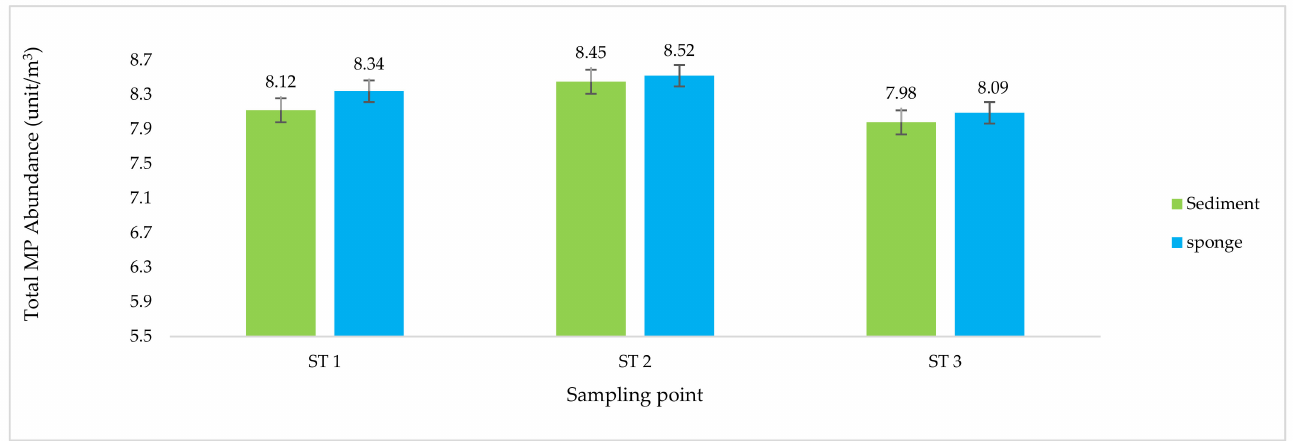
Figure 2. Total abundance of microplastics (MP) in the sediment and sponge samples based on the sampling points.